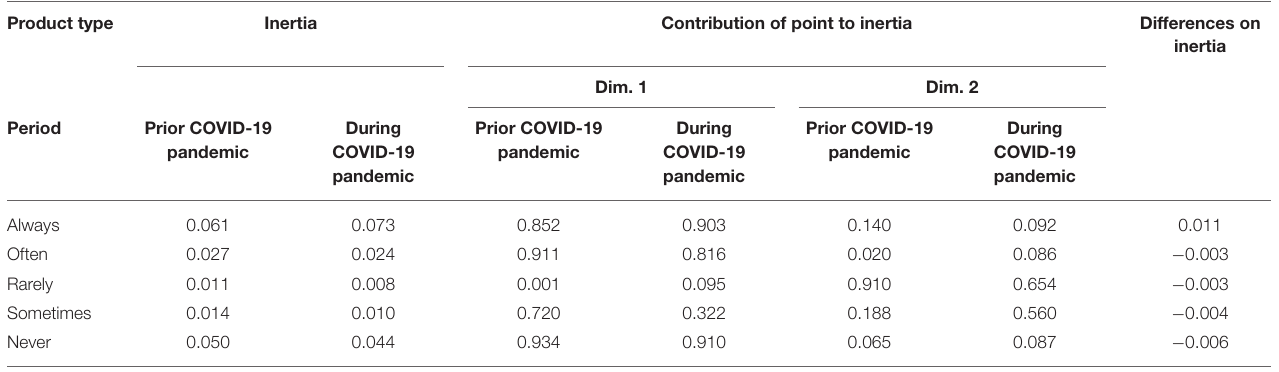
TABLE 5 | Inertia statistics on consumers’ ratings concerning likelihood of purchasing online. Product